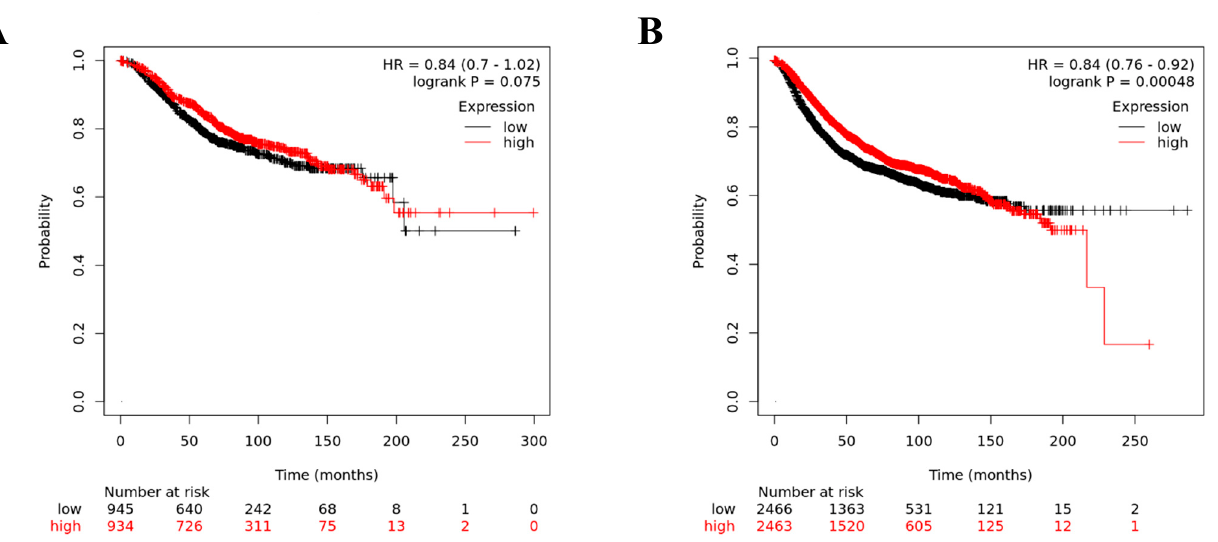
Figure 4. Kaplan–Meier survival curve of breast cancer patients based on GPC3 mRNA expression. ( A ) Overall survival (OS), and ( B ) relapse-free survival (RFS).